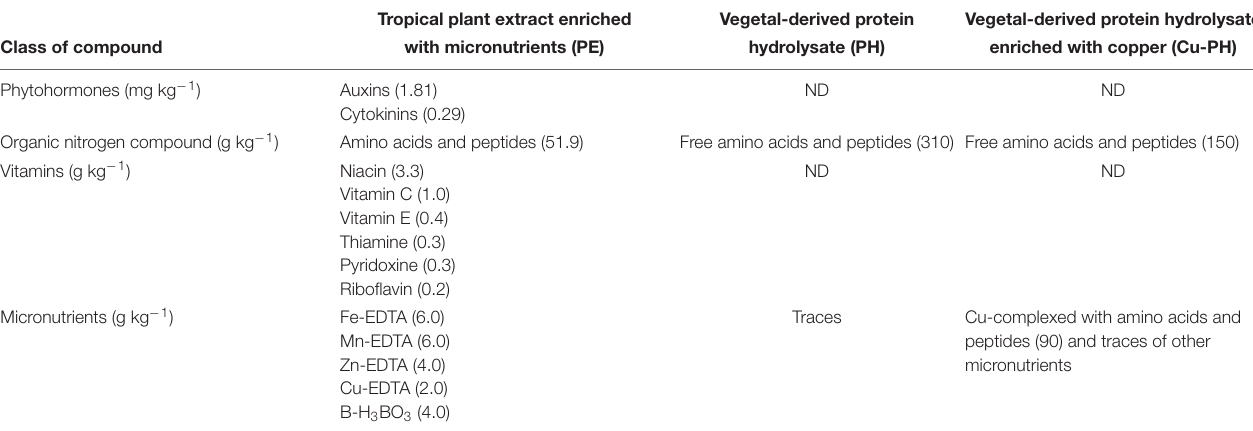
TABLE 1 | Main components of products tested in the lettuce trial. Tropical plant extract enriched Vegetal-derived protein Vegetal-derived protein hydrolysate Class of compound with micronutrients (PE) hydrolysate (PH) enriched with copper